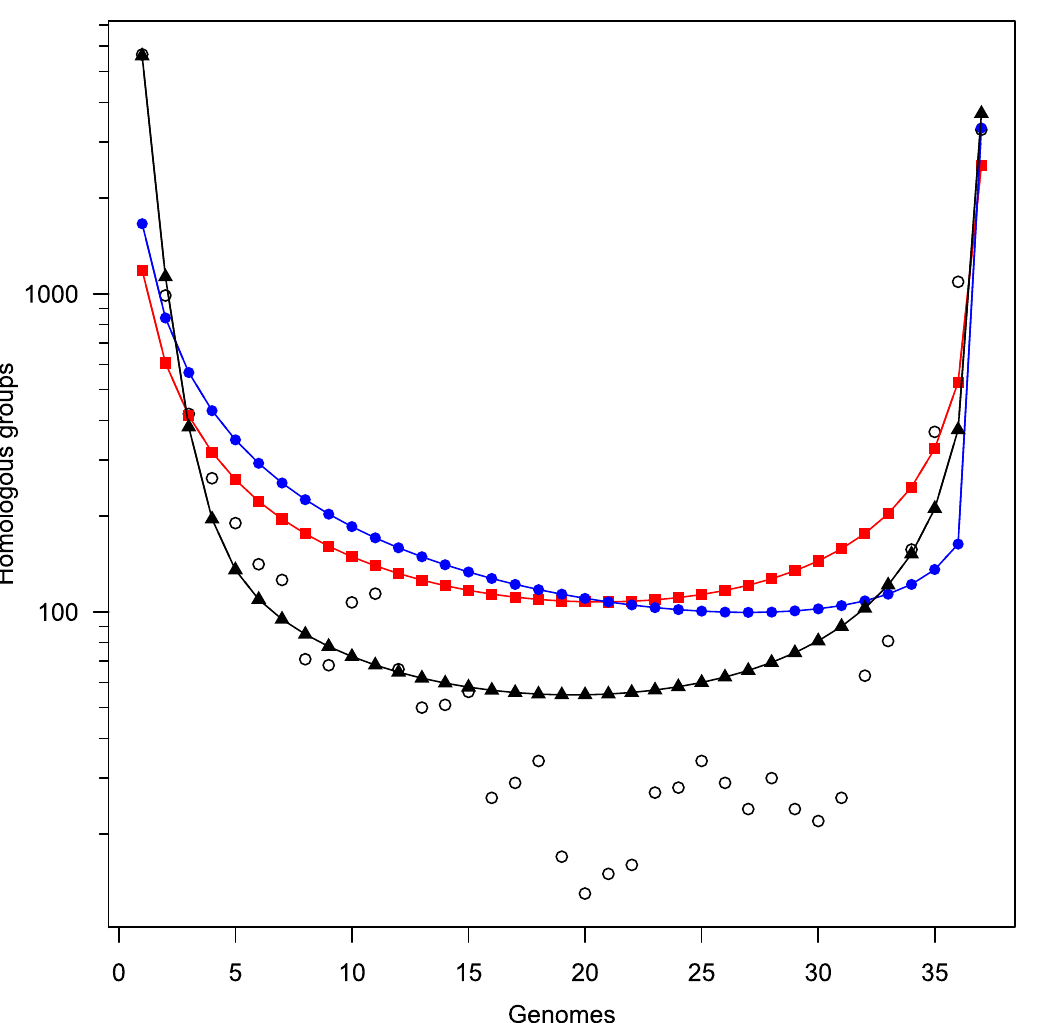
Fig 6. Distribution of genes and fit of models described by Haegeman and Weitz [10]. Open circles are data from this study, with fitted lines according to models A (red squares), C (blue filled circles), and D (black triangles). See Table 2 and text for descriptions of models and